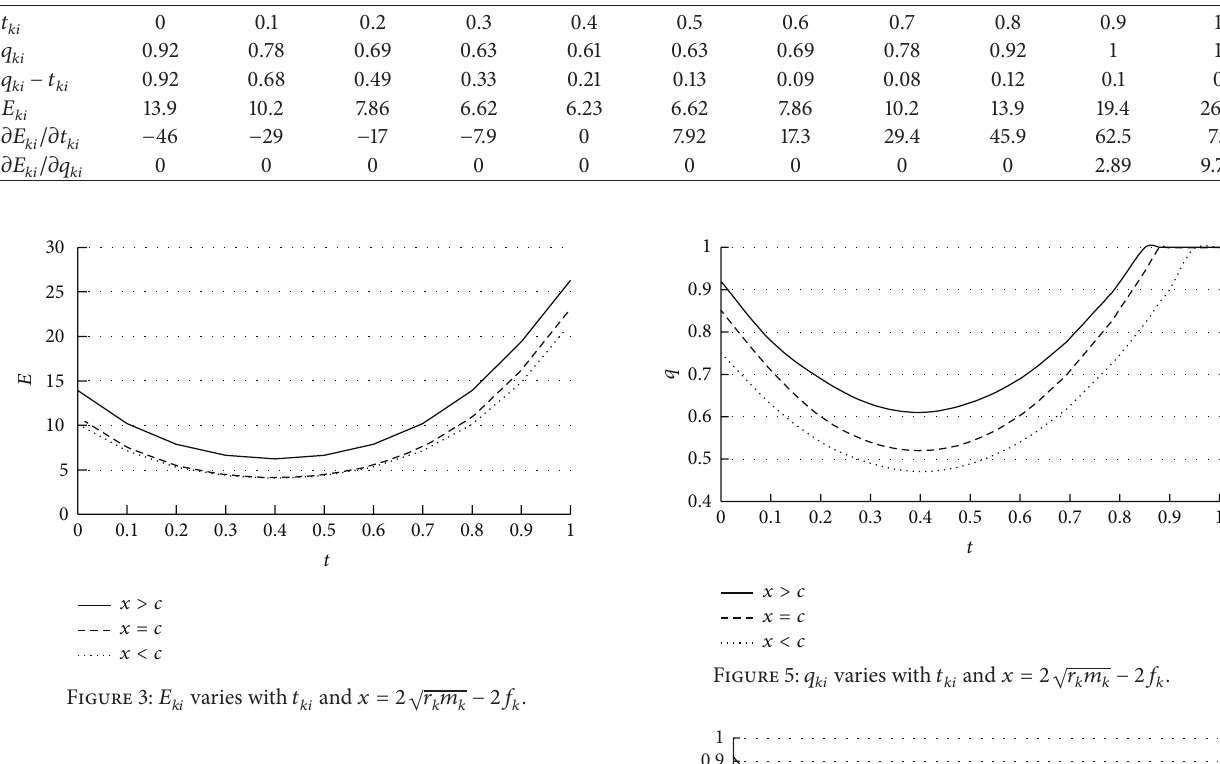
Table 3: 2√𝑟 𝑘 𝑚 𝑘 − 2𝑓 𝑘 > 𝑐 𝑘 , 𝑞 𝑘𝑖 = ((𝑟 𝑘 𝑡 2 𝑘𝑖 − 𝑐 𝑘 𝑡 𝑘𝑖 + 𝑚 𝑘 )/2𝑓 𝑘 ) , and the index values change with 𝑡 𝑘𝑖 .